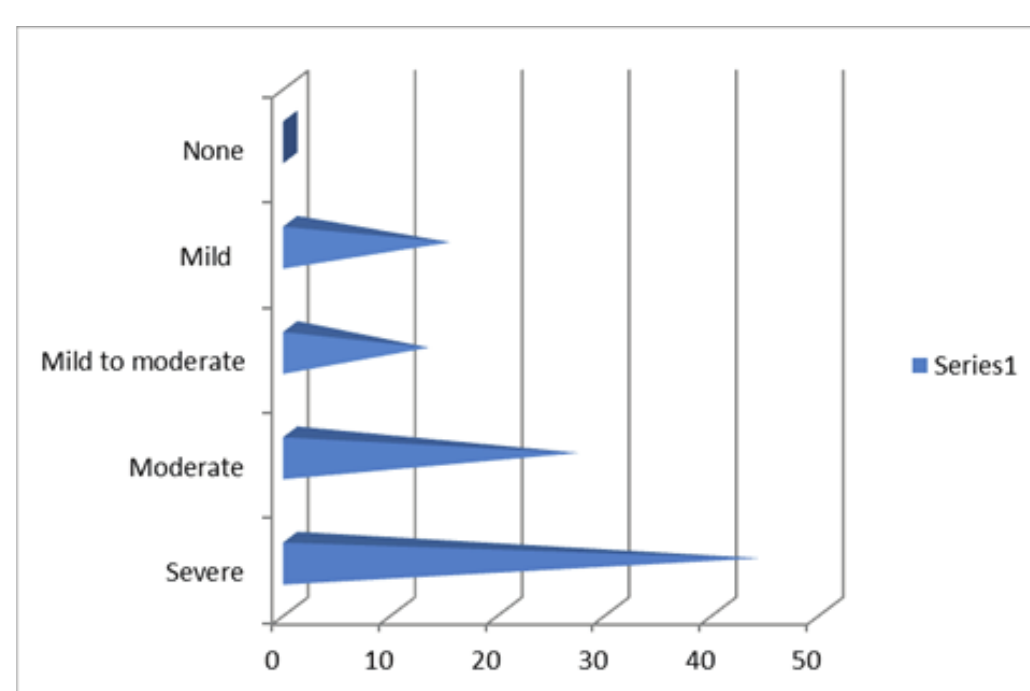
Figure 8: The overall sexual dissatisfaction among the studied group [based on the International Index of Erectile Function